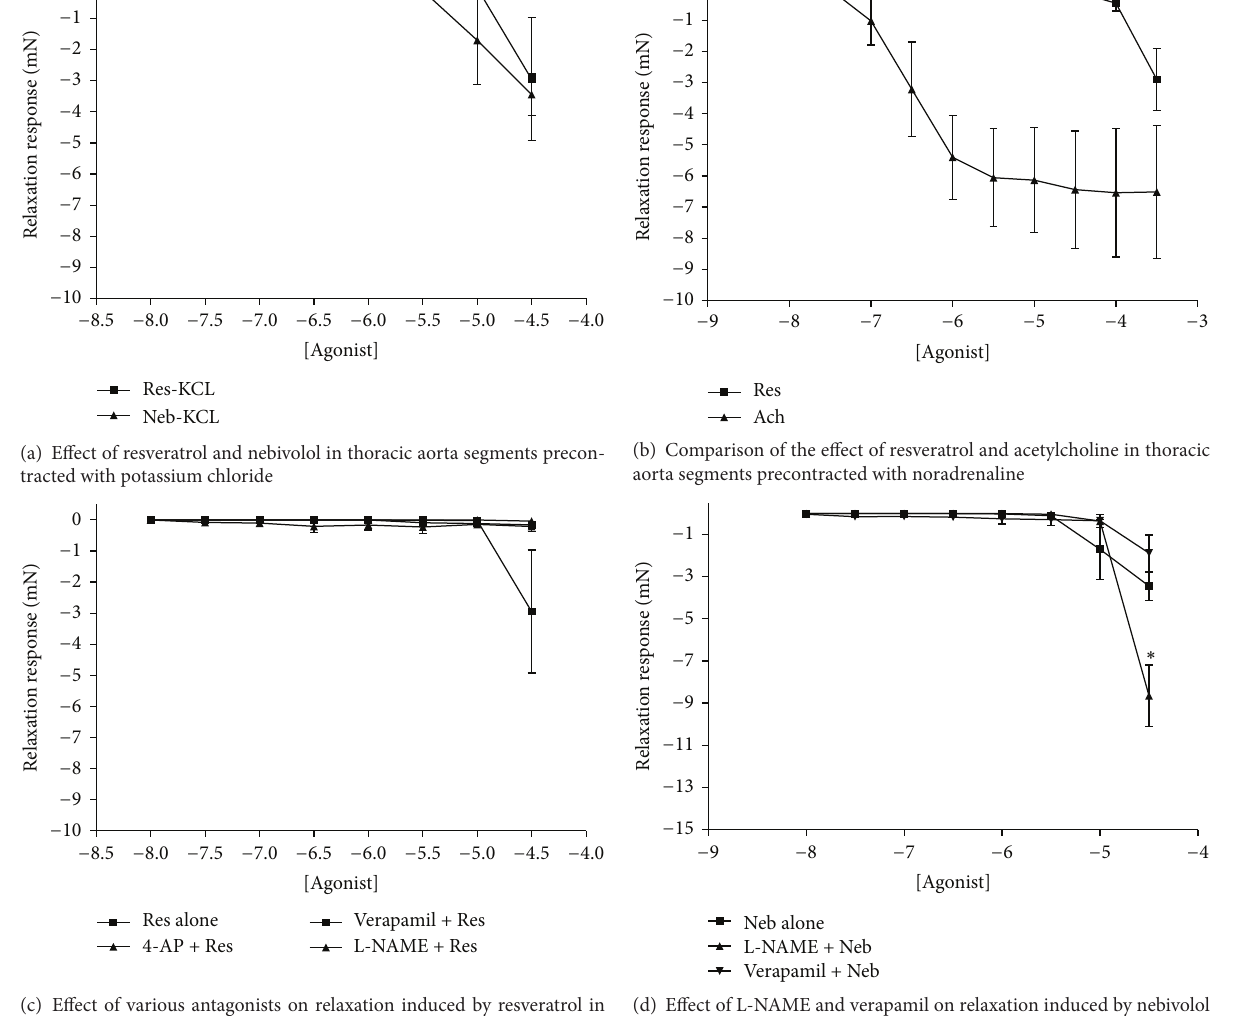
Figure2:Vasorelaxationinducedbytheadditionofeitherresveratrolornebivololinisolatedthoracicaorticsegments.KCL:tydrodessolution containing potassium chloride; Res: resveratrol; Neb: nebivolol; Ach: acetylcholine; 4-AP: 4-aminopyridine; L-NAME: N 𝜔 -nitro-L-arginine- methyl ester. ∗ 𝑃 < 0.05 ; data presented as mean ± SEM; 𝑛 = 9 for all